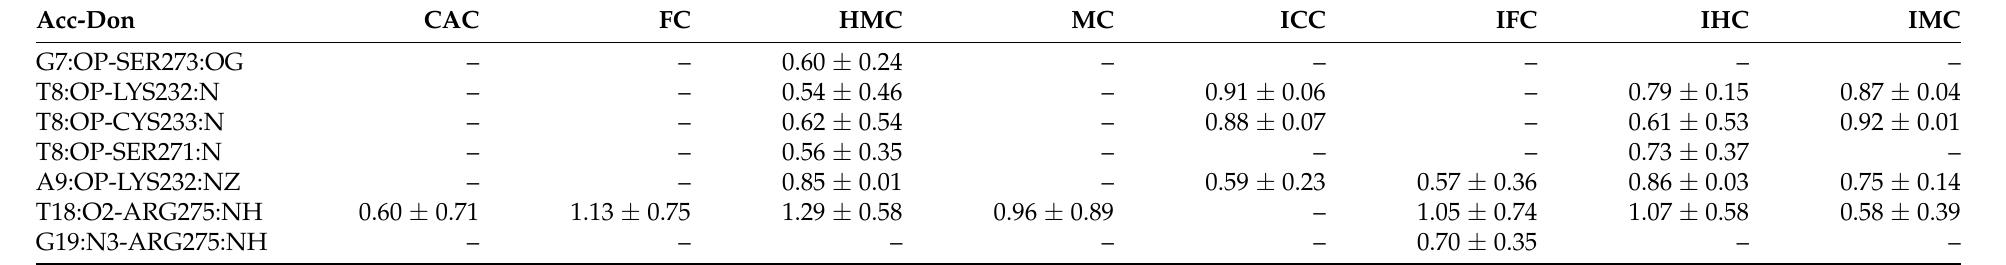
Table 5. Probabilities of hydrogen bonds between the protein and the DNA but not the G:XC pair. Only hydrogen bonds that have a probability of at least 0.5 in at least one of the models are